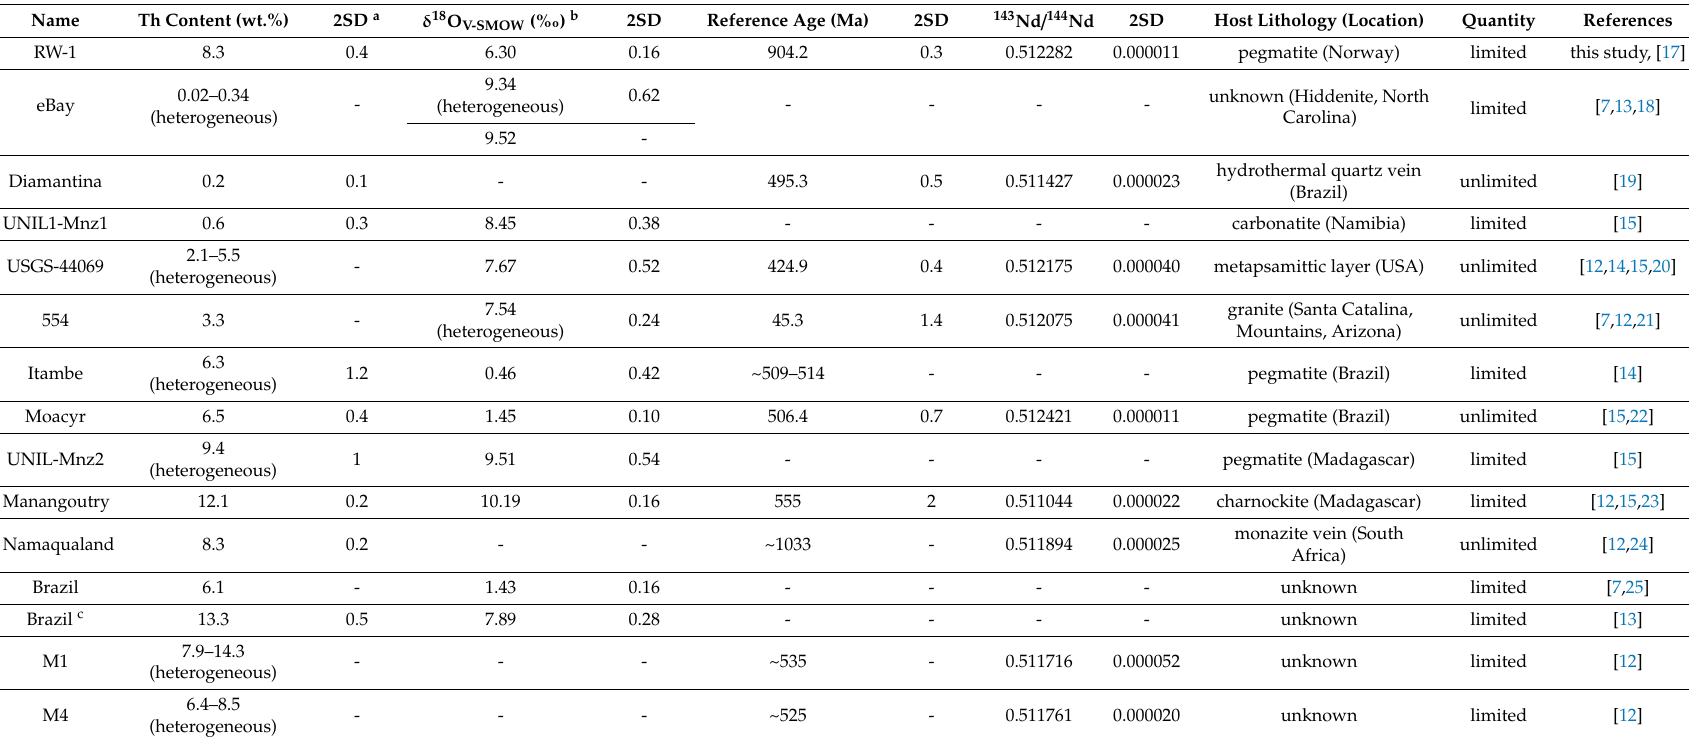
Table 1. Compilation of previously investigated monazite reference